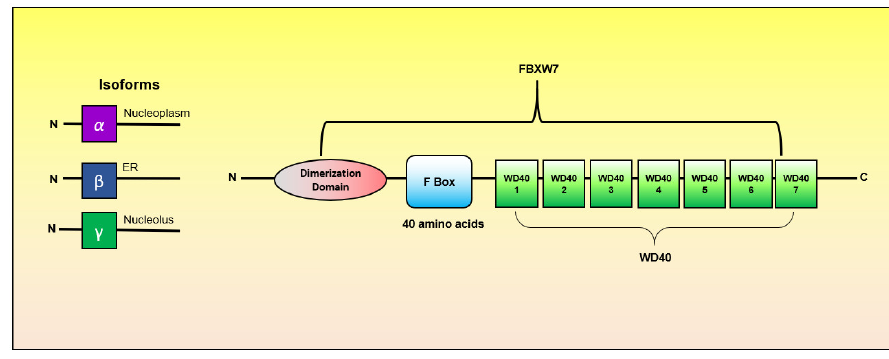
Figure 2. Structure of FBXW7.